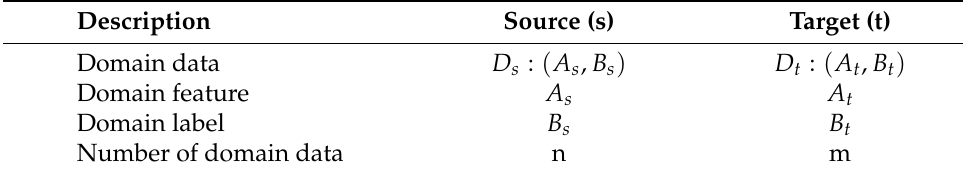
Table 2. Symbols and